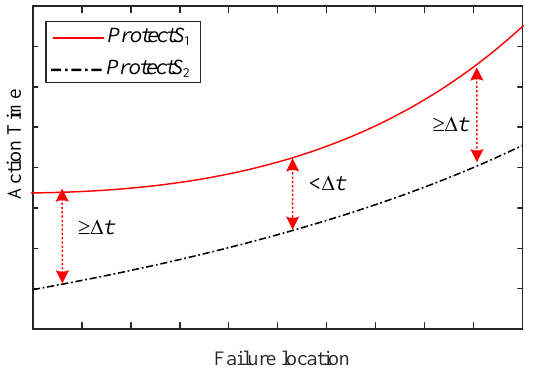
Figure 8. Schematic diagram of protection mismatch.